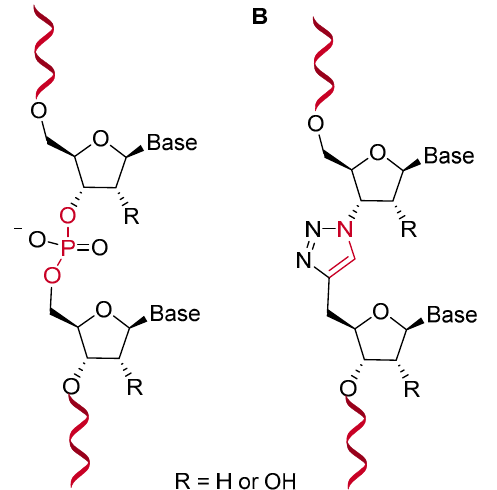
Figure 3. Structure of natural nucleic acids ( A ) and triazole-linked analogues ( B ). The natural O-P-O phosphate linkage is substituted by an artificial N-C-C triazole linkage.